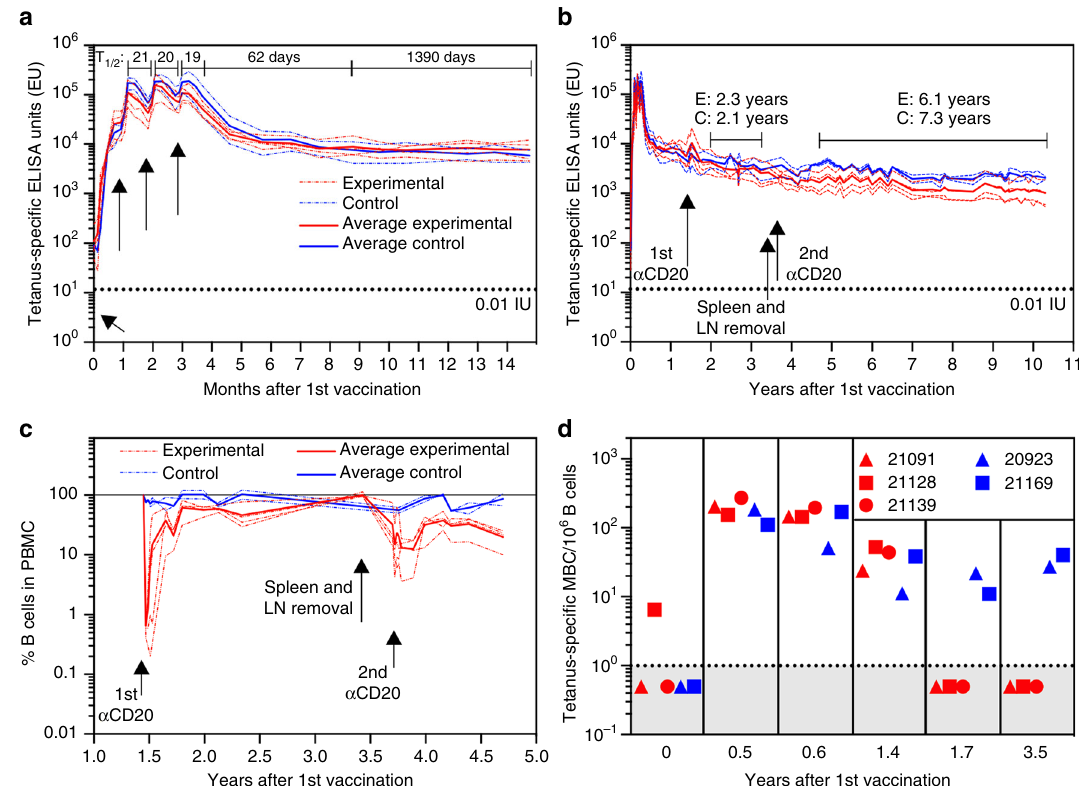
Fig. 1 Tetanus-speci fi c antibody responses following memory B cell depletion. Six Rhesus macaques received 4 intramuscular doses of Tripedia ® vaccine (arrows, panel a ) and tetanus-speci fi c serum antibody responses were monitored closely for 15 months a to 10 years b . CD20 + B cells were depleted from 4 experimental animals (Experimental; E) at the indicated time points by administration of anti-CD20/Rituximab ( b , c ) and these animals also underwent splenectomy and surgical removal of draining lymph nodes (LN) at 3.5 years after primary vaccination. Two control animals (Control; C) were monitored in parallel throughout the experiment to compare tetanus-speci fi c antibody levels and memory B cell frequencies. Ef fi ciency of B cell depletion was determined by staining PBMC for CD22 + B cells c and tetanus-speci fi c memory B cells were directly measured by fl ow cytometry either before or after memory B cell depletion performed at 1.5 years after vaccination d . The dashed line in a and b represents the tetanus-speci fi c ELISA titer coinciding with 0.01 IU/ml calibrated based on the international serum standard, Tetanus Immunoglobulin TE-3. The dashed line in d indicates the limit of detection. Further details describing the statistical model for determining antibody decay rates and half-life estimates can be found in the Methods (Eqs. 1 and